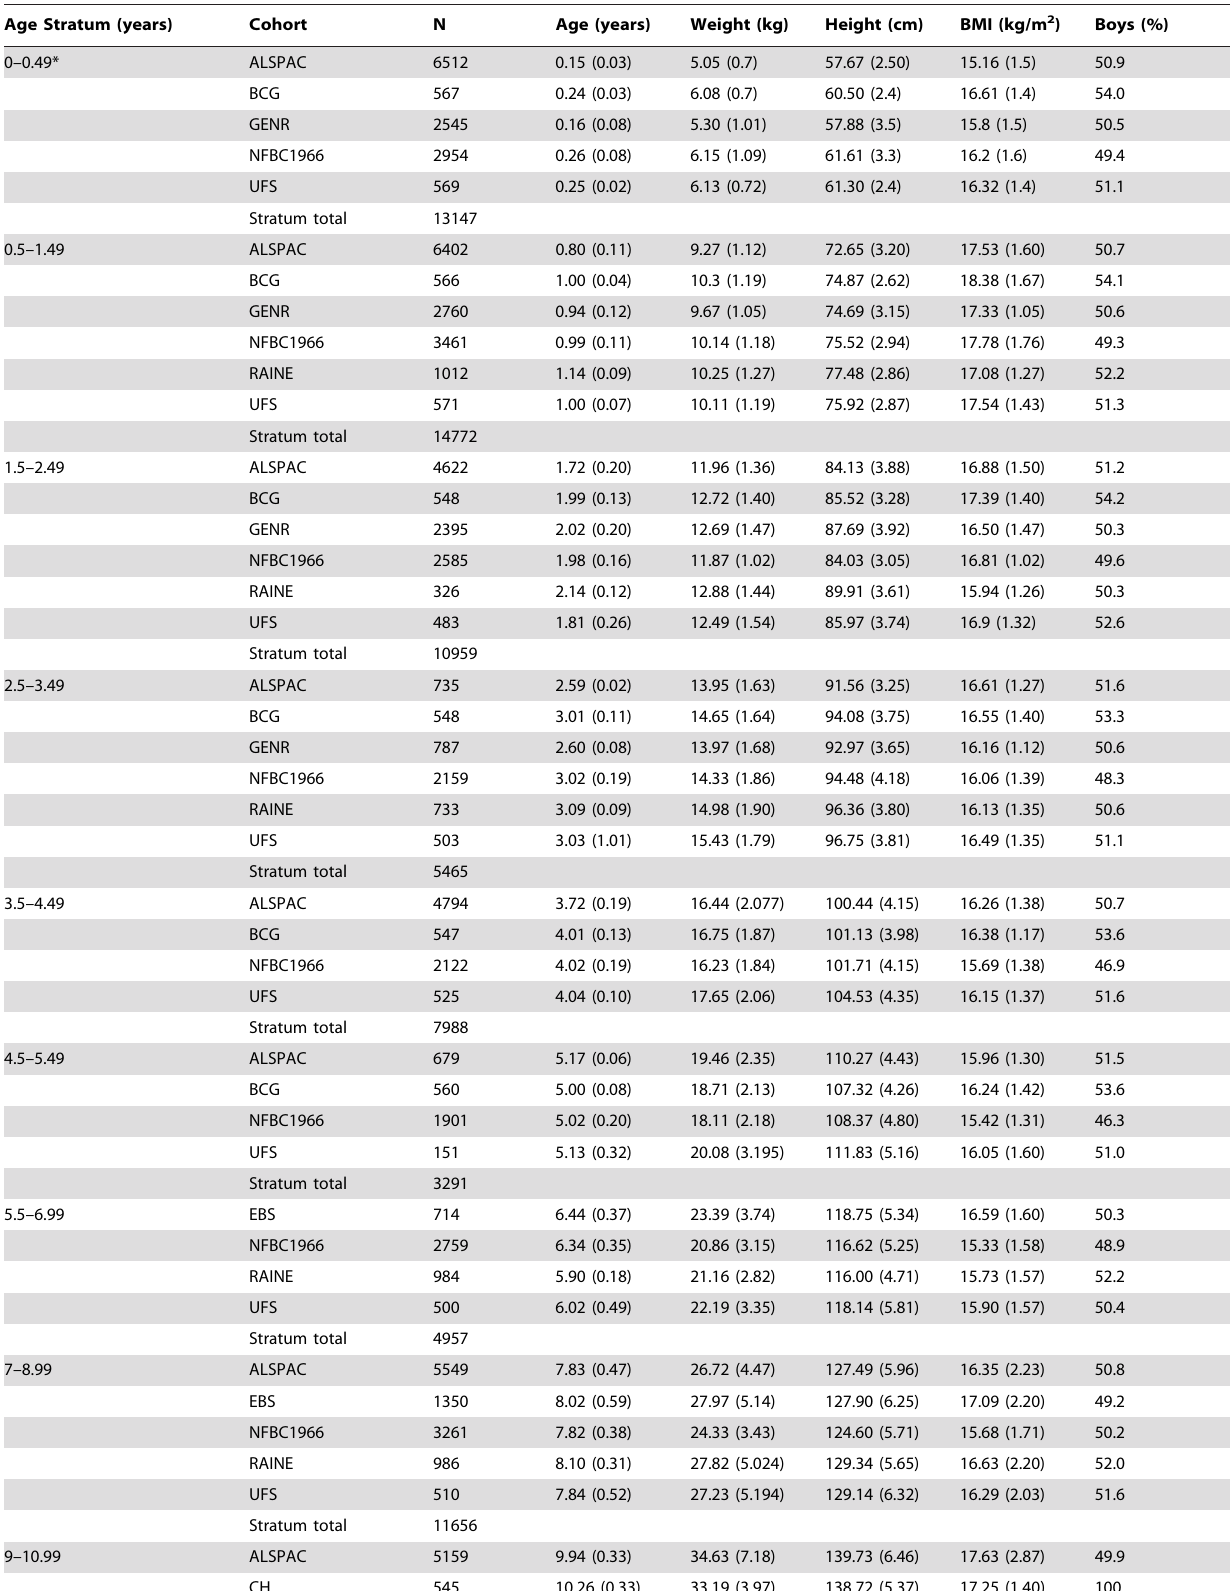
Table 1. Numbers and characteristics of subjects by cohort and age